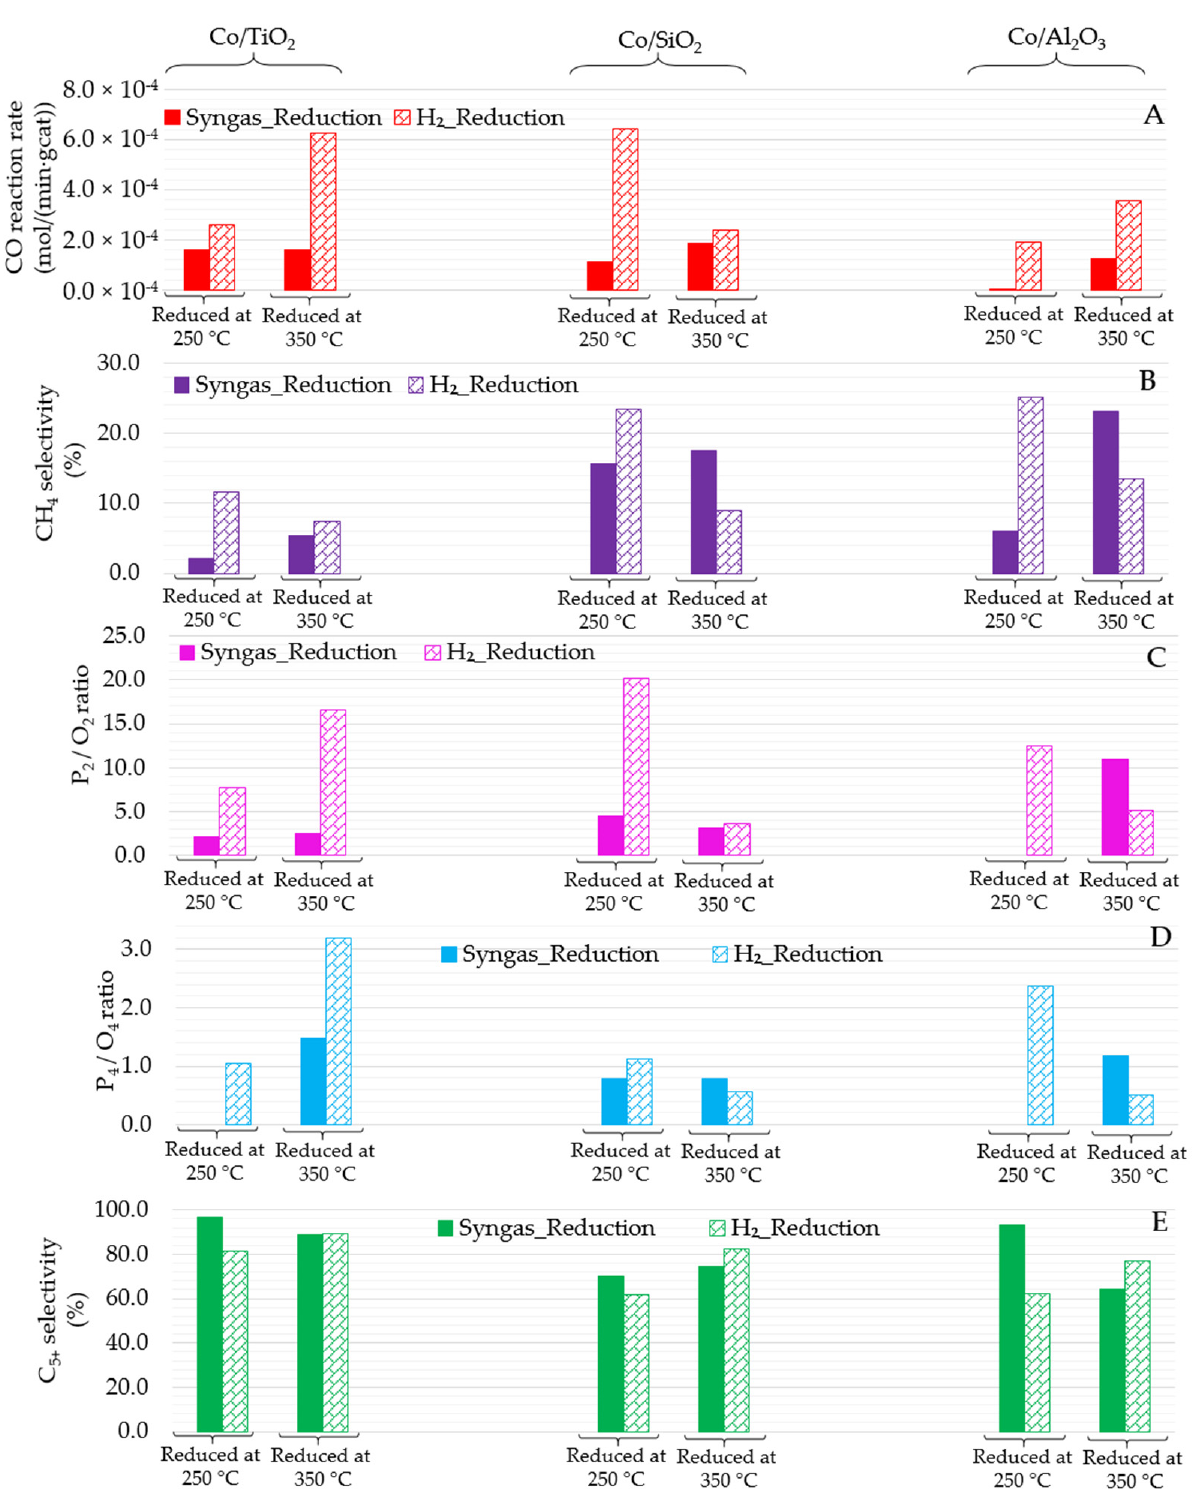
Figure 10. CO reaction rate and product selectivity as a function of reducing agent and temperature: ( A ) CO reaction rate, ( B ) CH 4 selectivity, ( C ) P 2 /O 2 ratio, ( D ) P 4 /O 4 ratio, and ( E ) C 5+ selectivity. Reaction conditions: 20 bar, 60 mL/min, and 210 ◦ C. P 2 /O 2 refers to the ratio of ethane/ethylene; P 4 /O 4 refers to the ratio butane/butene. The CO reaction rates were found to be higher at a higher reduction temperature (350 ◦ C) for all the samples, except for the syngas pre-treated TiO 2 -supported sample and H 2 -pre-treated SiO 2 -supported sample. The SiO 2 -supported catalyst showed